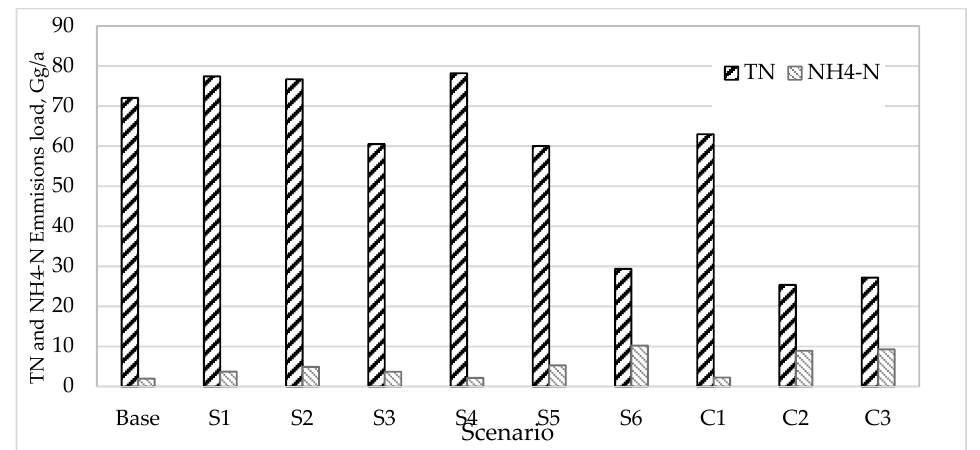
Figure 8, good and/or better compliance with the discharge standard is preserved for both Figure 9. Effluent load of TN and NH 4 -N in a year with the tested strategies. parameters in all tested scenarios, because peaks are flattened.